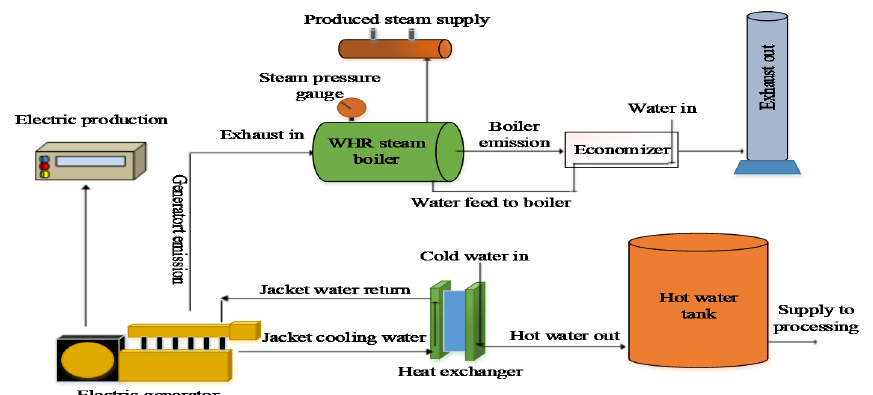
Fig. 3: Cooling water heat recovery from electric generator jacket water, with steam generation from Whr Boiler and